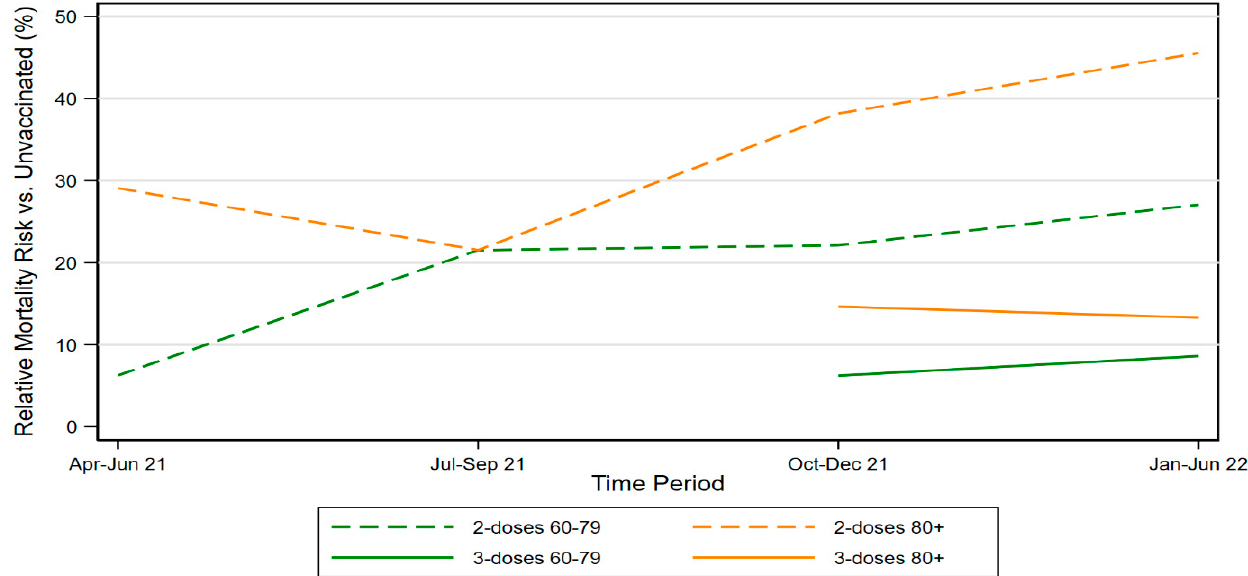
Figure 3. RMR for Two-Dose and Three-Dose Elderly Vaccinees. Figure shows two-dose and three- dose relative mortality risk (RMR) versus the unvaccinated, by time period, for persons aged 60–79 and aged 80+.